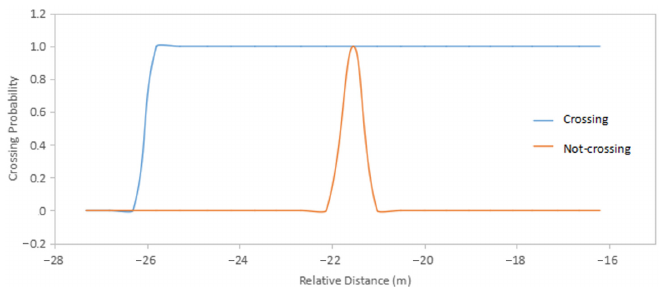
Figure 13. Pedestrian crossing intention prediction with longitudinal relative distance between pedestrians and vehicle in different scenarios.